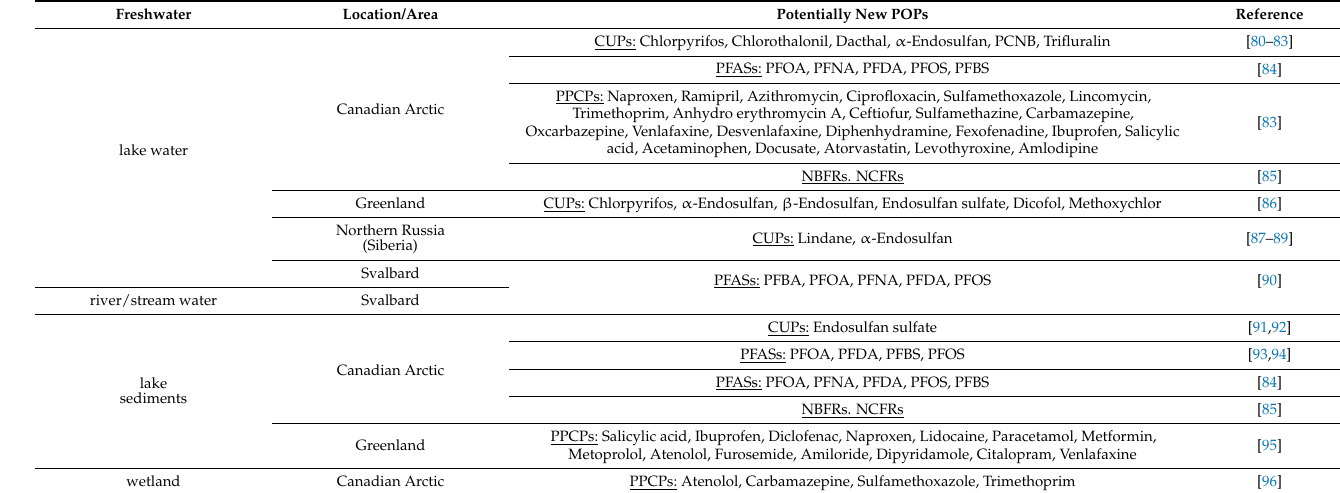
Table 2. Examples of potentially new classes of POPs detected in the freshwater environment of the Arctic.